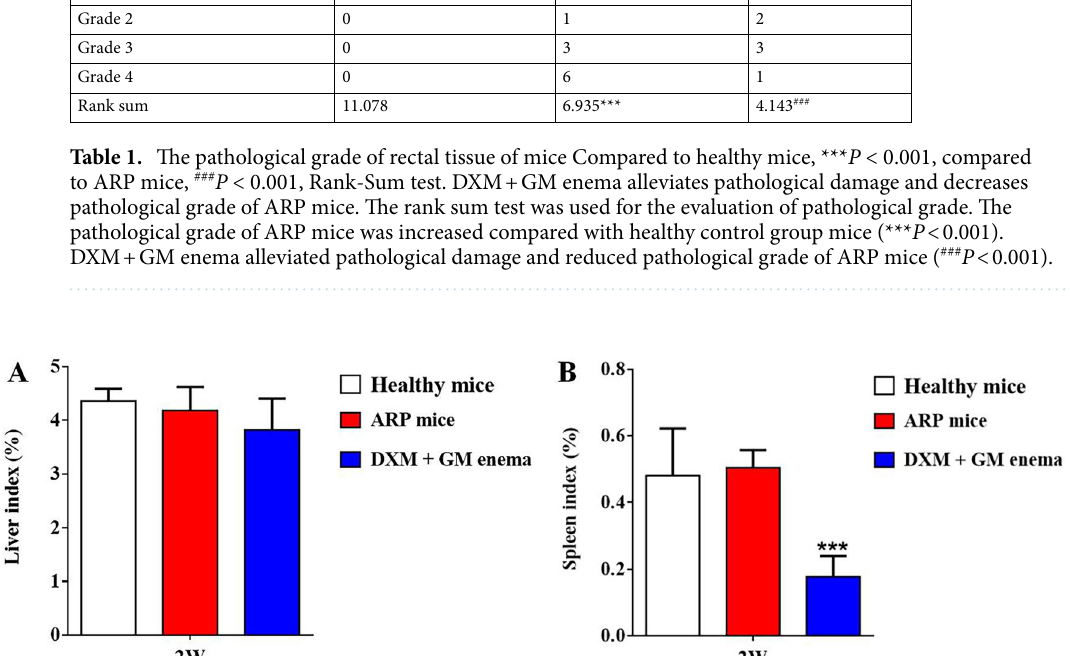
these 15 downregulated genes, Il13ra2 (Interleukin 13 Receptor alpha 2), Ttc7 (tetratricopeptide repeat domain 7) and Gsdmc (gasdermin C) were significantly decreased in ARP mice. There were 587 differential genes in ARP mice before and after treatment of DXM + GM enema (Fig. 3B). The number of upregulated genes was 348, whereas that of downregulated genes was 239 (Fig. 3B). Based on transcriptome sequencing data, we found that 15 of the 348 upregulated genes and 15 of the 239 downregulated genes were associated with the effects of DXM + GM enema treatment. Among these 15 upregulated genes, Ttc7 , Phlpp2 (PH domain and leucine-rich repeat protein phosphatase 2), Ikbkg (inhibitor of kappaB kinase gamma, formerly known as NF-kB essential modulator, NEMO), Gsdmc and Sumo3 (small ubiquitin-like modifier 3) were significantly upregulated after